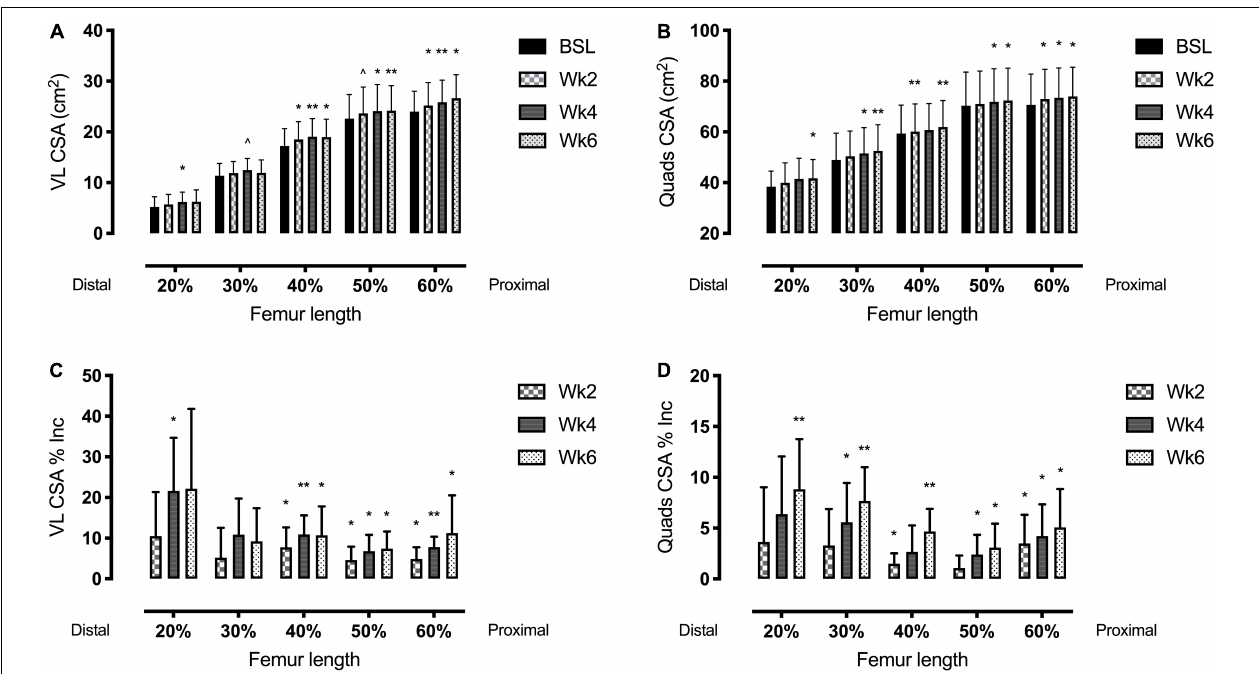
FIGURE 4 | Vastus lateralis (VL) (left side, A,C ) and quadriceps femoris (right side, B,D ) muscle cross-sectional area (CSA) adaptations to a 6-week plyometric training measured after 2, 4, and 6 weeks. Top panels represent muscle CSA changes in absolute values (cm 2 ). Bottom panels represent muscle CSA percentage changes ( (cid:49) %). Results are shown as Means ± SD. ∧ p = 0.05, * p < 0.05, **p <